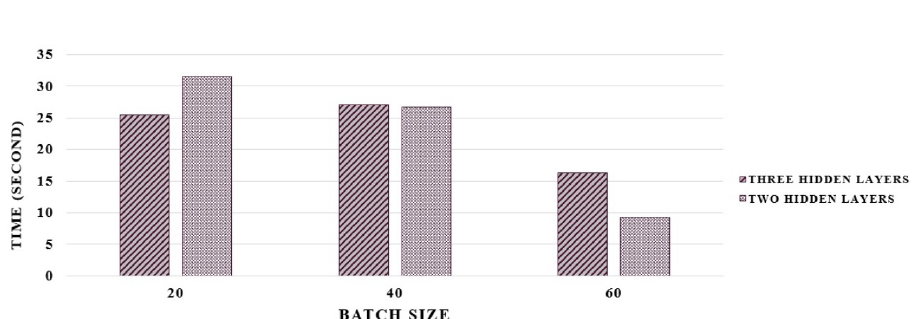
Figure 9. Proposed CGAN model’s training